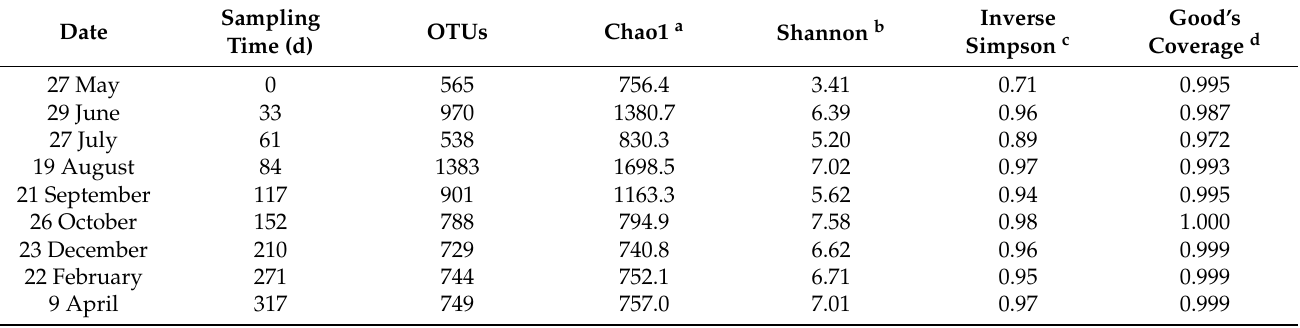
Table 1. Operational taxonomic units (OTUs) and alpha-diversity indices for the bacterial soil community.